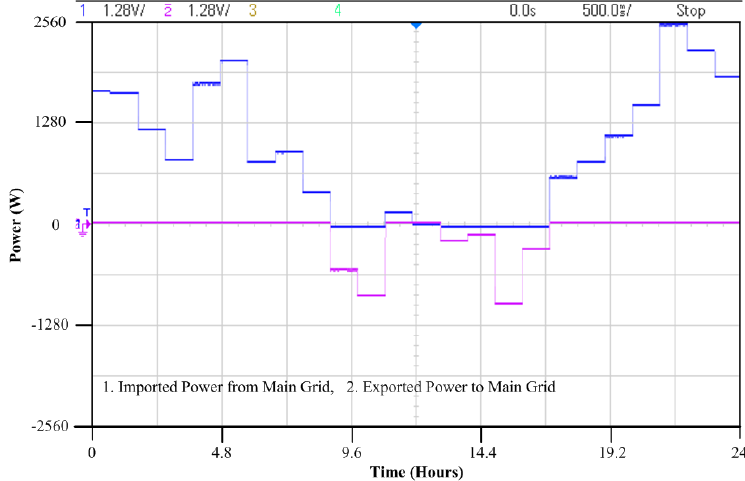
Figure 13. Grid power for